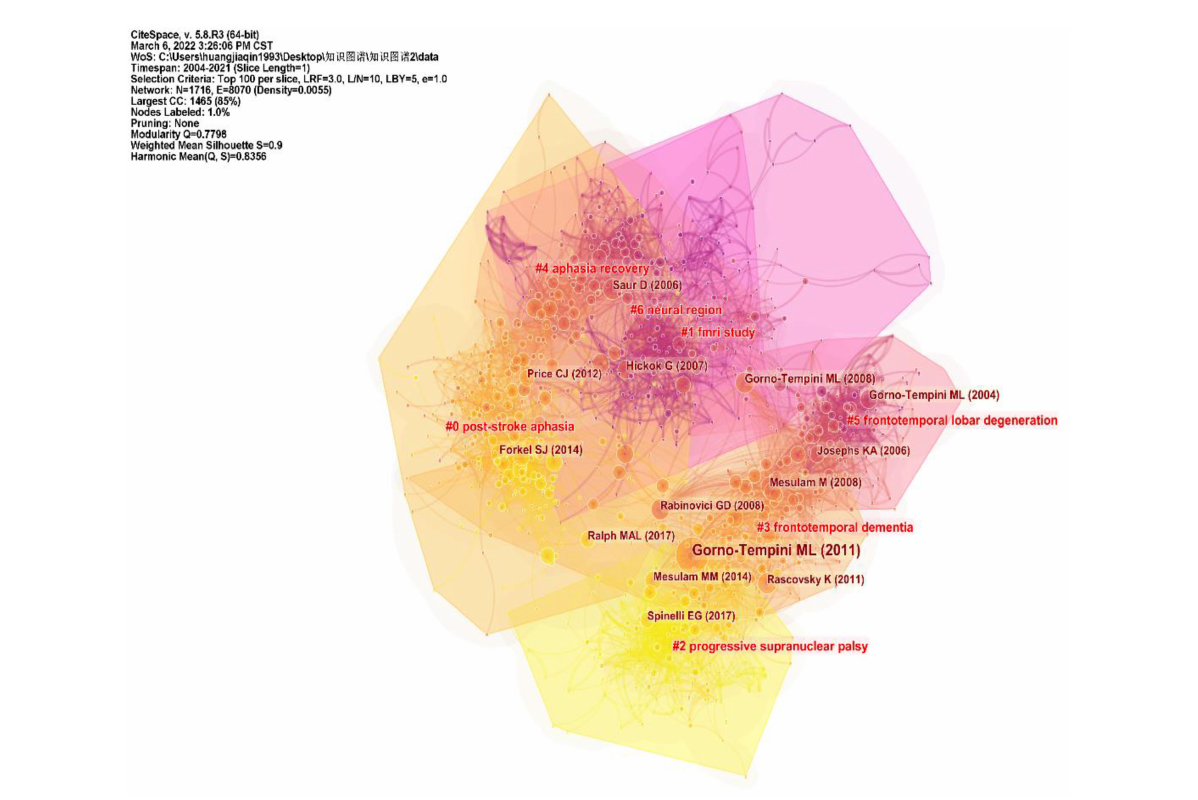
FIGURE7 Trajectories of relevant research shown in a hybrid network of co-cited references and burst terms from titles and